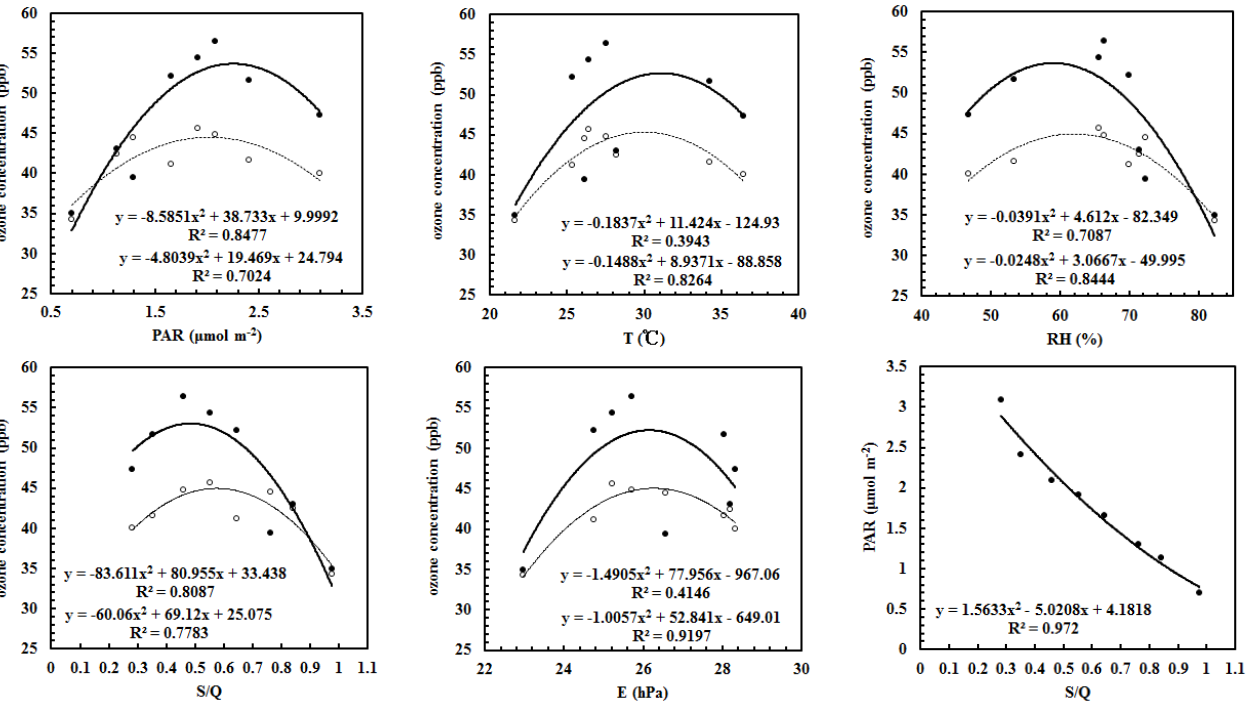
Figure 7. The relationships between O 3 concentration and its influencing factor, as well as between the observed PAR and S/Q, dark dot and circle denote the calculated and observed O 3 , respectively. The regression equations were obtained for a polynomial